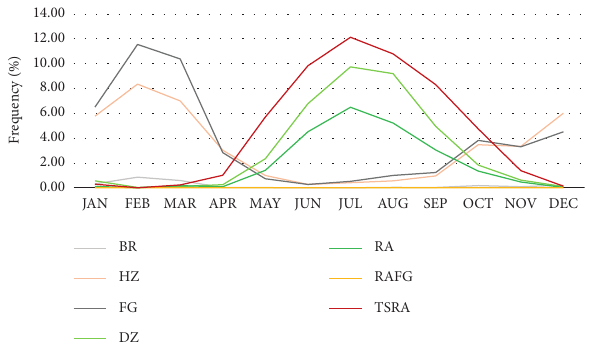
Figure 10: Climatology of monthly frequencies (%) of weather phenomena (2009–2019).